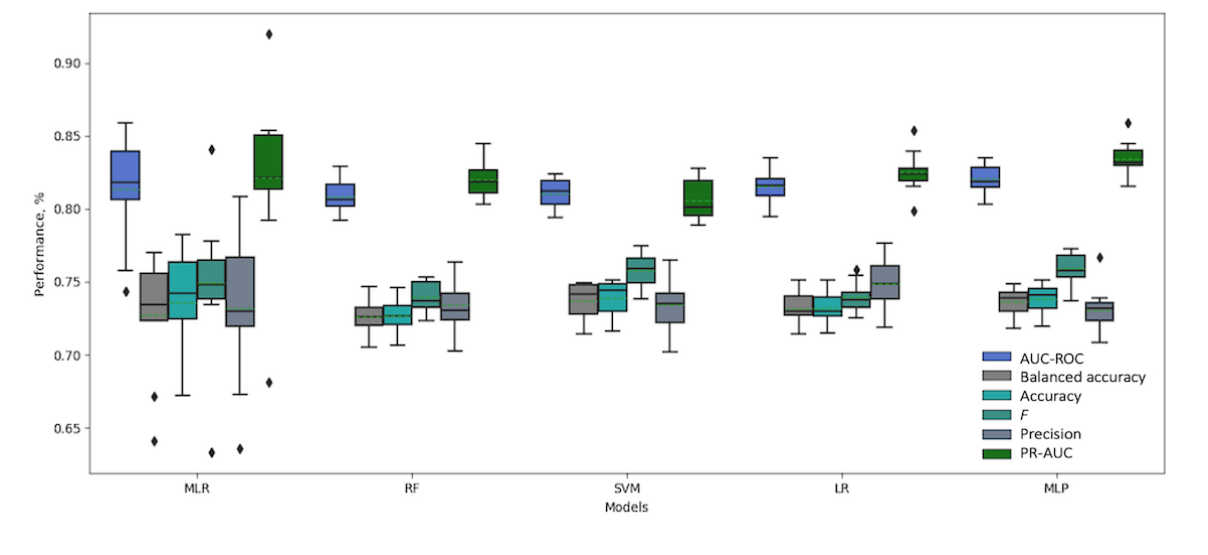
Figure 4. Box plot showing the detailed 10-fold performance of all models trained without longitudinal data. AUR-ROC: area under the receiver operating characteristic; LR: logistic regression; MLP: multilayer perceptron; MLR: multiple logistic regression; PR-AUC: precision-recall area under the curve; RF: random forest; SVM: support vector machine.